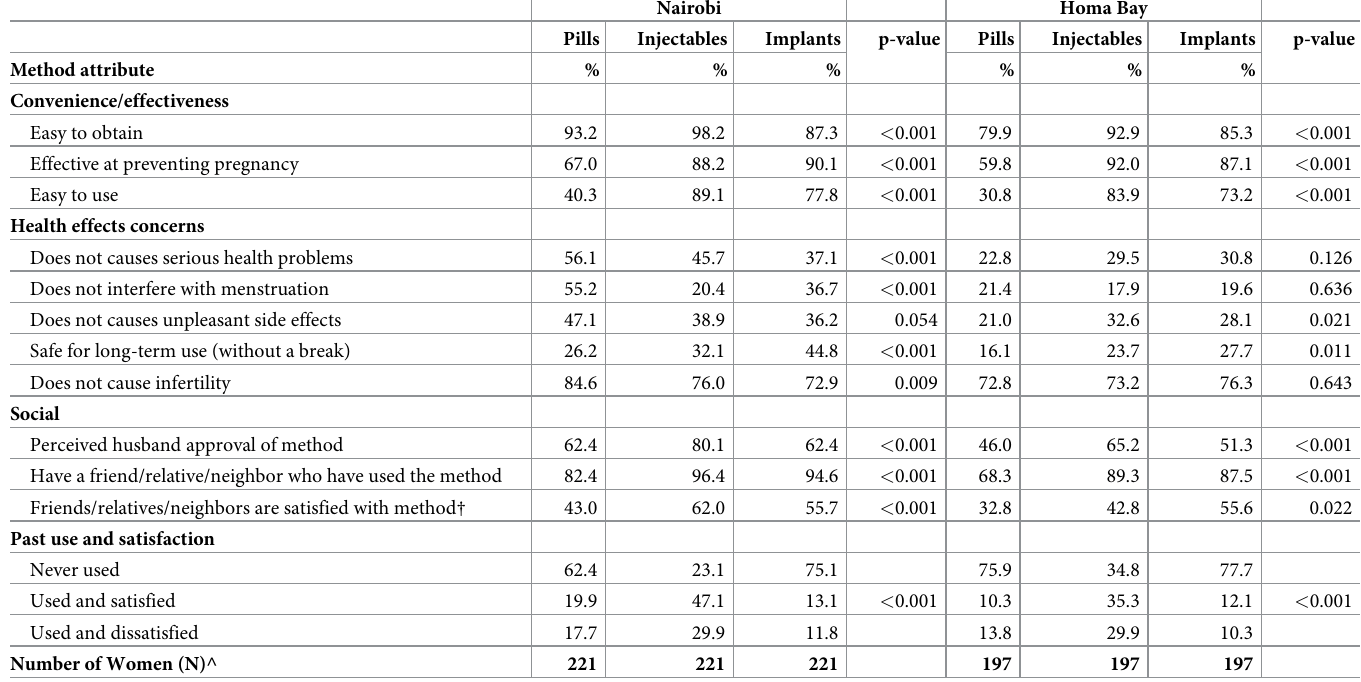
Table 2. Among women who were not using any method at baseline and adopted pills, injectables or implants at 12-month follow-up, the percentage with specific perception about these